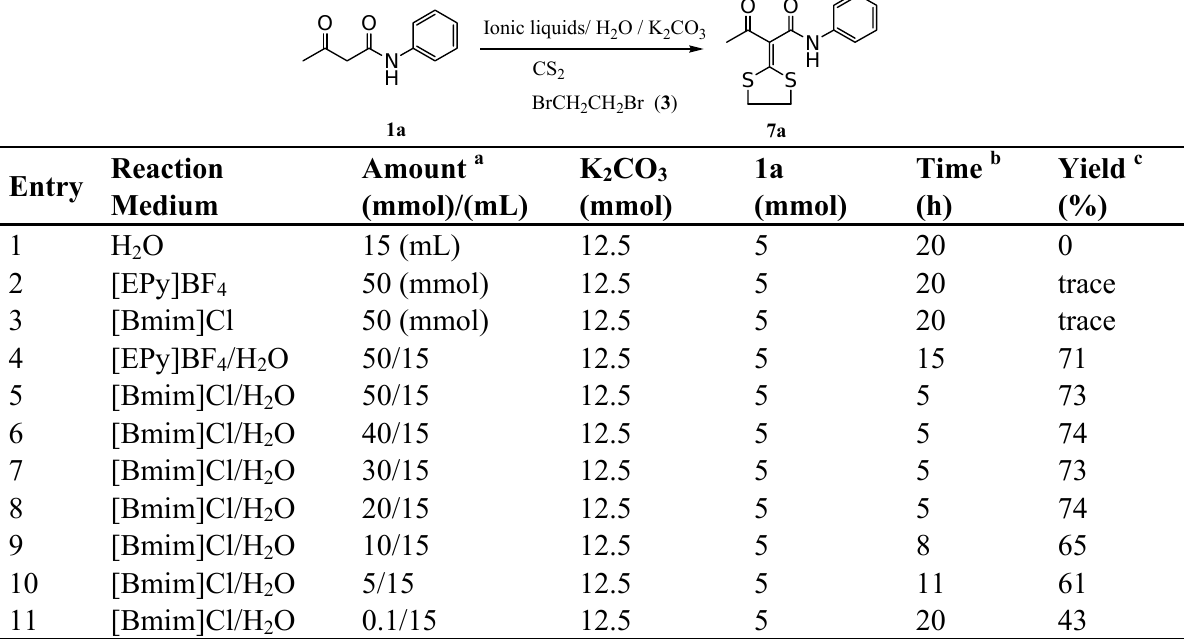
Table 1. Reaction of 1a with carbon disulfide and 1,2-dibromoethane in ionic liquids/water under different conditions.